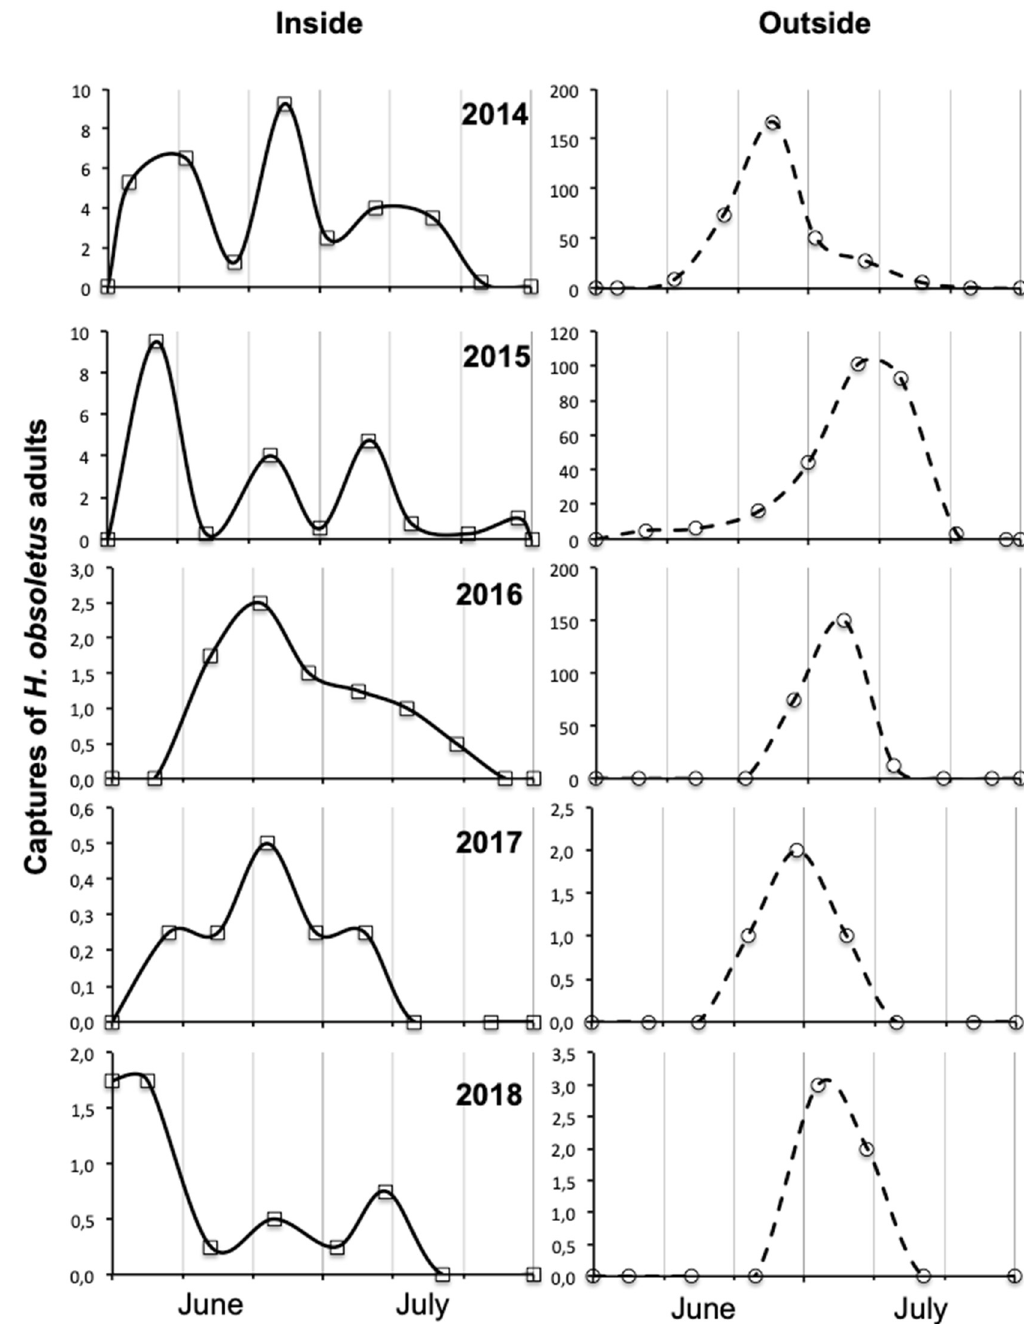
Figure 3. Hyalesthes obsoletus captured on yellow sticky traps during 2014–2018 both inside and outside vineyard A. A value of captures for outside refers to the sum of seven traps and for inside to the sum of the average of each of seven series.